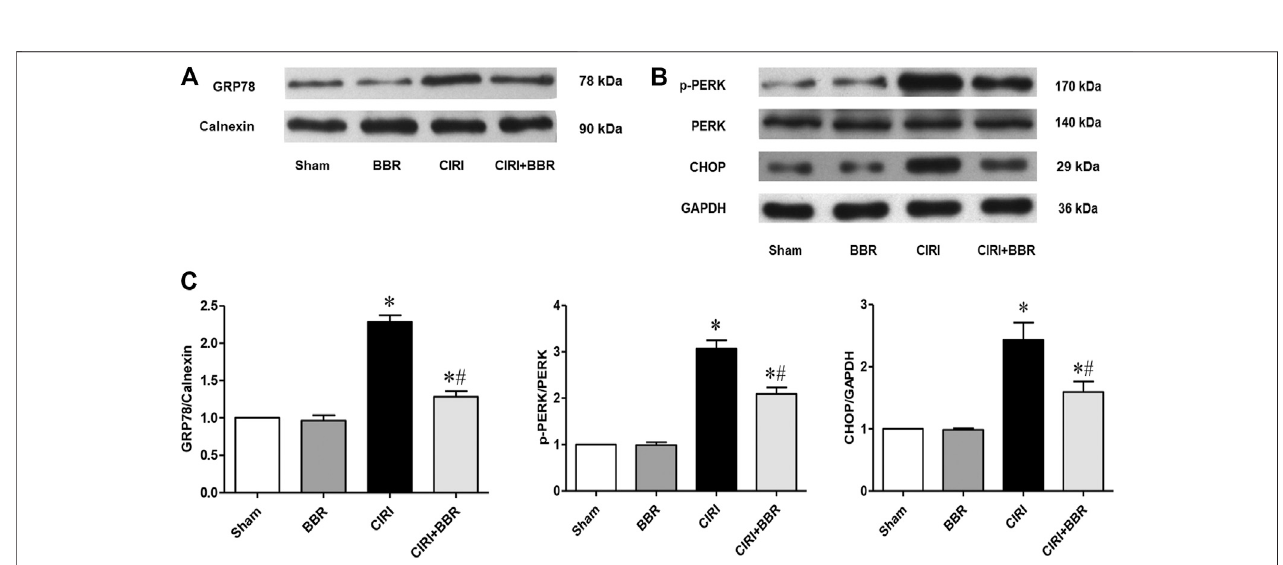
FIGURE 3 | BBR attenuates neuronal apoptosis in cortical ischemic penumbra by inhibiting the ERS pathway. The ERS-related proteins GRP78 (A) , p-PERK/ PERKandCHOP (B) fromcorticalischemicpenumbraweredeterminedbyWesternblot.GAPDHwasusedastheloadingcontrol. (C) ,Bargraphshowingthestatistical comparison of GRP78, p-PERK/PERK and CHOP protein levels across groups. n (cid:2) 6. Data are shown as the mean ± SEM. * p < 0.05 compared with Sham group; # p < 0.05 compared with the CIRI group.